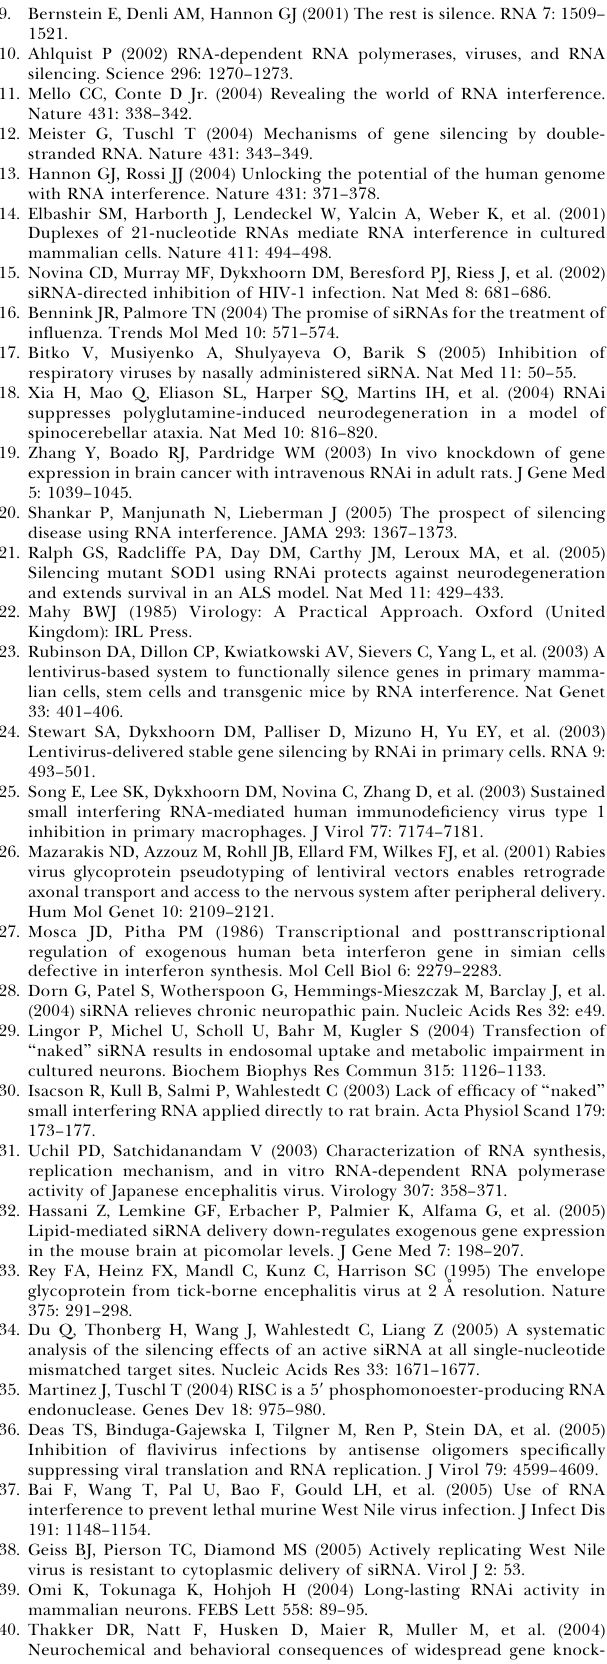
Figure S1. FvE J Does Not Induce a Type I IFN Response (A) Mock- or lentivirally transduced Vero cells were challenged with JEV at a MOI of 10, and viral replication monitored 72 h later by flow cytometry after staining with a JEV-specific antibody. Percentage of infected cells is indicated. (B) cDNA prepared from Neuro 2a cells stably transduced with shLuc- or shFvE J - (left), or shLuc- or shFvE J - injected mouse brains obtained 4 h (middle) or 24 h (right) after injection were subjected to RT-PCR to measure the induction of IFN-response genes. The PCR products were quantified by NIH Image J (version 1.32j) software. Normalized values obtained for the test samples were divided by that obtained with untreated Neuro 2a cells or untreated mouse brains to determine the changes in mRNA levels for each of the